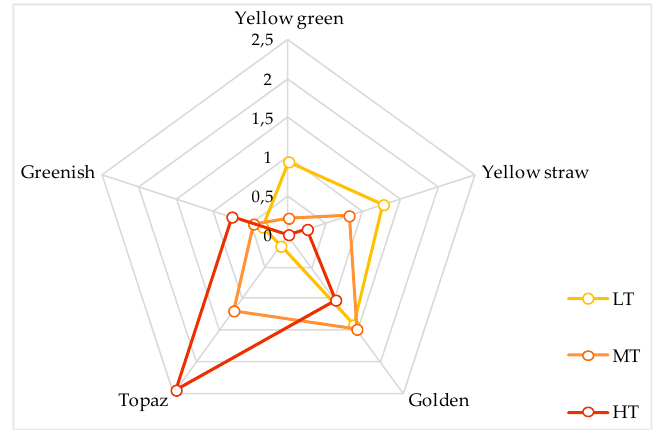
Figure 7. Color profile based on the average panel score’s attributes of the wine spirits aged during four years in barrels with different toasting levels (LT—light toasting; MT—medium toasting; HT—heavy toasting). For each color attribute, the differences between the aged wine spirits are very significant ( p < 0.01). Adapted from [23].